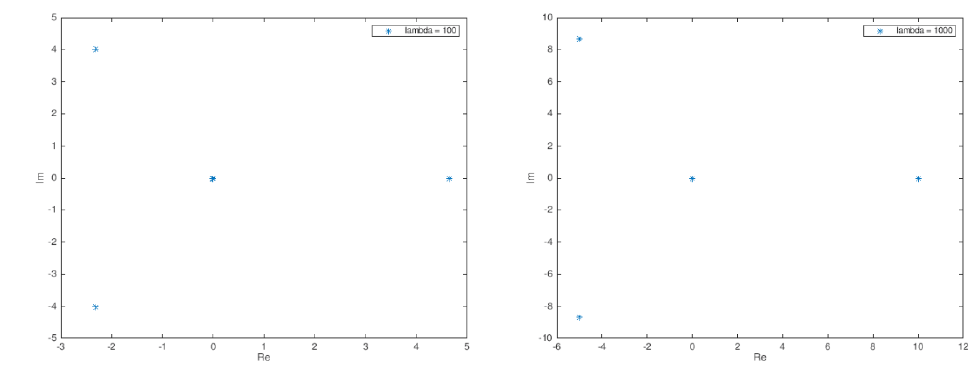
Figure 8. Eigenvalues of the matrix A for λ = 100 and λ =